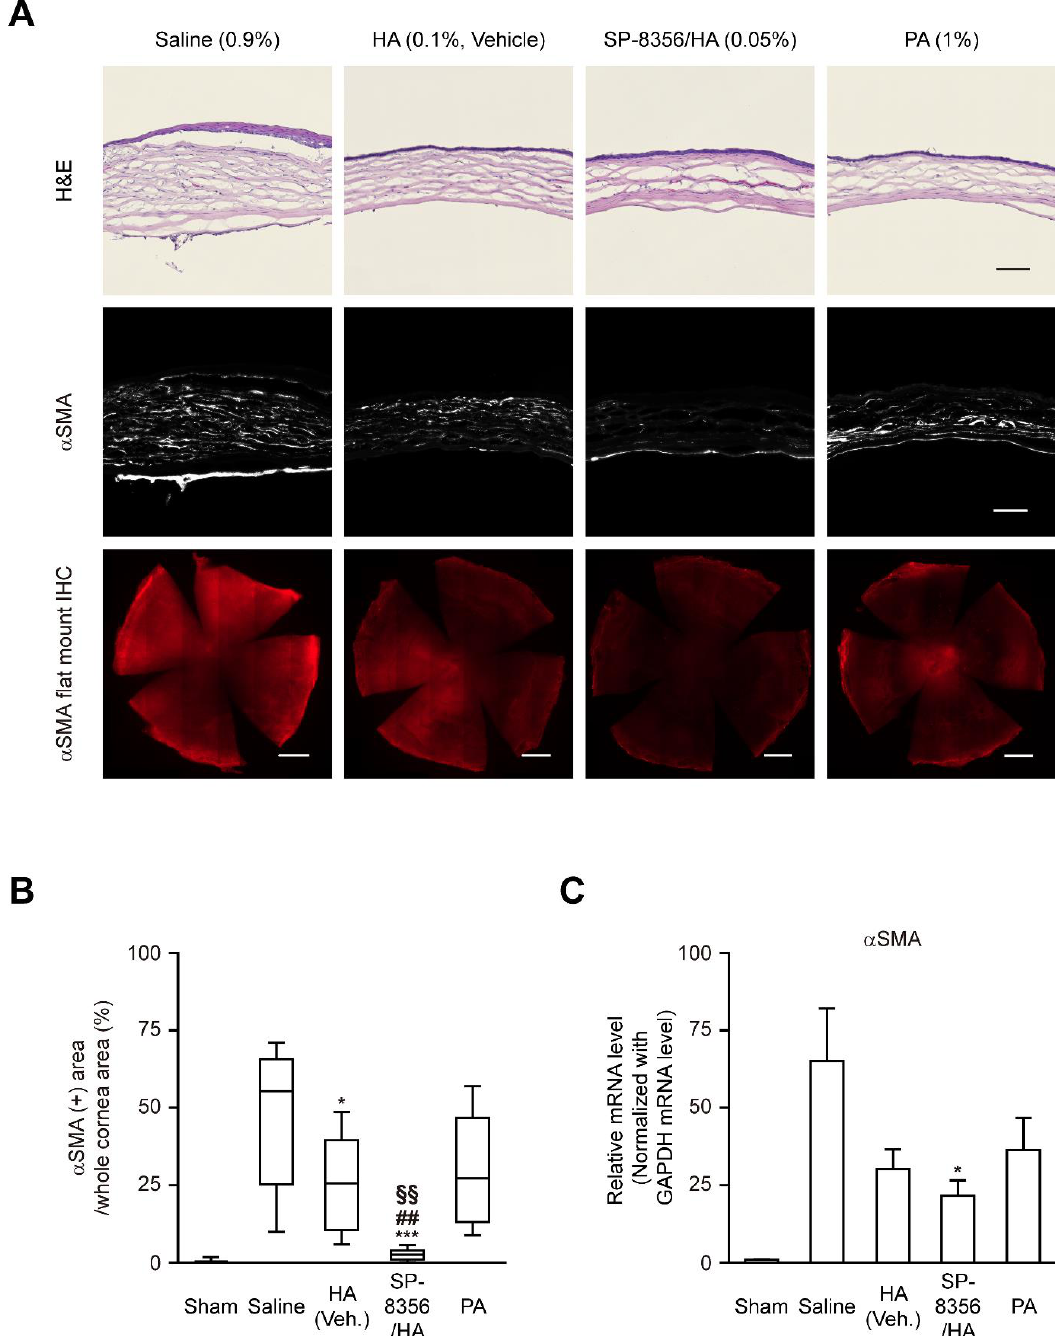
Figure 2. SP-8356 inhibits myofibroblast population in cornea at 2-week after alkali burn. ( A ) Representative images of myofibroblast population. Alkali-burned whole cornea sections were flat-mounted and stained with hematoxylin and eosin (H&E) and anti-αSMA antibody. Scale bars for corneal H&E and immunostaining, 100 μm (magnification, 200×). Scale bar for flat-mounted whole cornea immunostaining, 1 mm. ( B ) Quantitative analysis of αSMA in the whole cornea ( n = 7 for sham, n = 8 for saline, n = 10 for HA, n = 9 for SP-8356/HA, n = 10 for PA). All values are shown as means ± SD (* p < 0.05 vs. saline. *** p < 0.001 vs. saline. ## p < 0.01 vs. HA. §§ p < 0.01 vs. PA). ( C ) Quantitative analysis of the relative mRNA level of αSMA ( n = 9 for sham, n = 10 for saline, n = 10 for HA, n = 10 for SP-8356/HA, n = 10 for PA). The mRNA levels are shown as means ± SD (* p < 0.05 vs. saline).